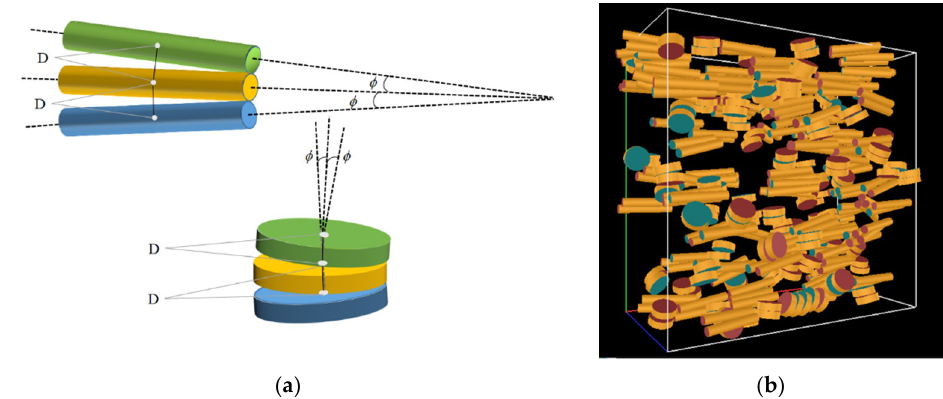
Figure 4. ( a ) An illustration of the criterion to determine a stacking structure, and ( b ) formation of stackings in a shear flow of a binary mixture of rods ( AR = 6) and disks ( AR = 0.3). The non-stacking particles are removed from the image (b).